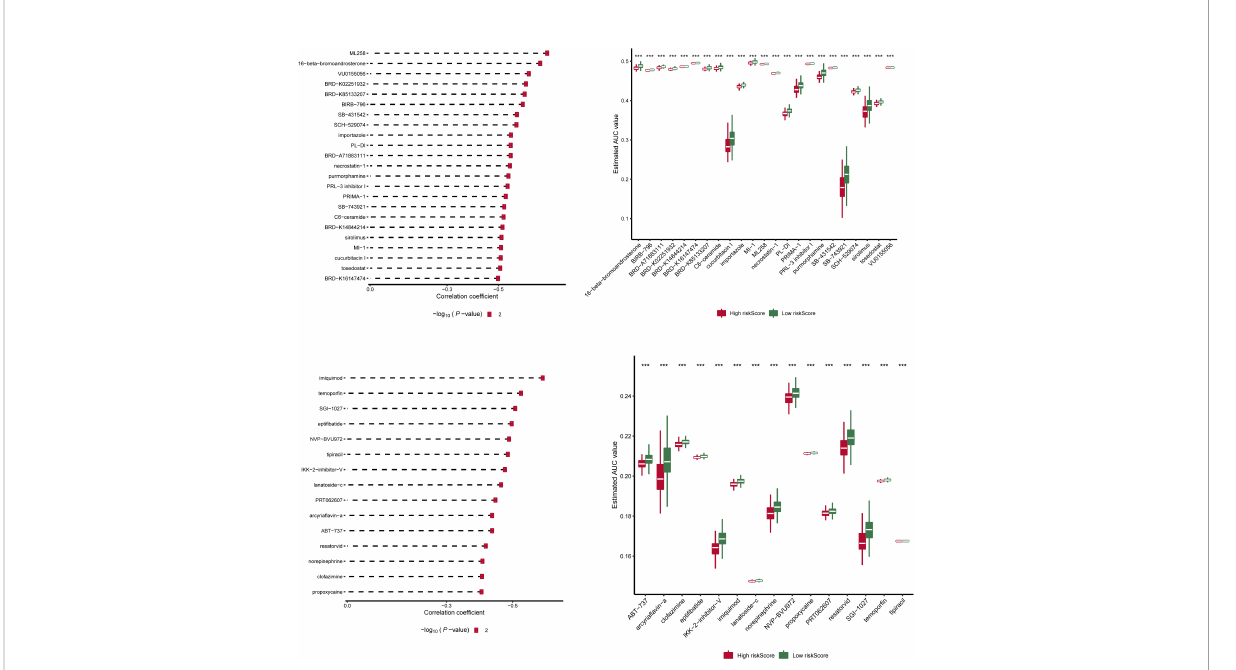
FIGURE 6 Drug sensitivity analysis of risk scores in two groups. Information on the sensitivity of tumor cell lines to potential drugs was downloaded from CTRP v2 and PRISM. Prediction of drug susceptibility in two groups using pRRophetic. The lower the AUC of the cell line, the higher the sensitivity to the potential drug. AUC, area under the curve. ***p < 0.001